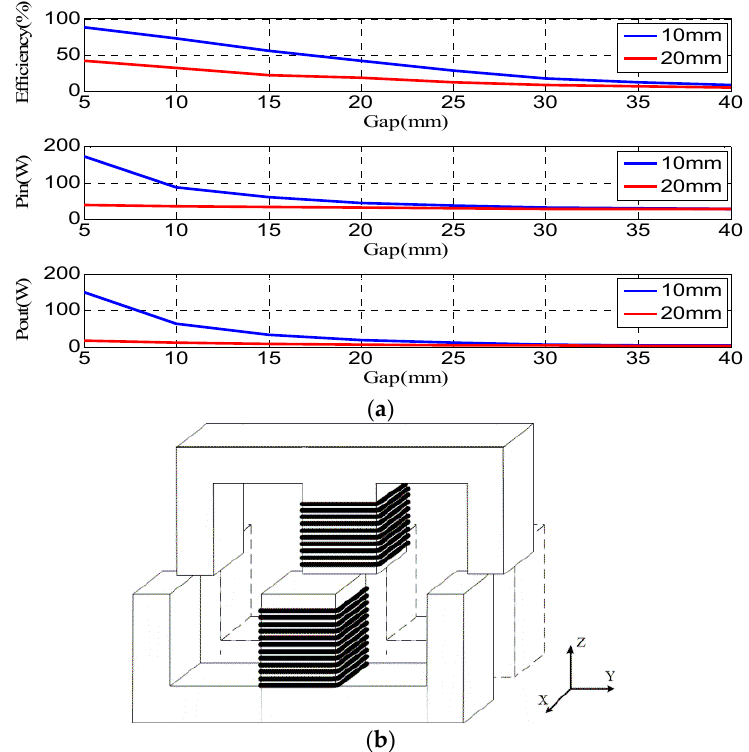
Figure 7. Dislocation effect of the IPT system with varied air gap from 5 mm to 40 mm (fsw: 20 kHz). ( a ) Efficiency, input power; and output power ( b ) Dislocation. Table 5. Dislocation effect of the IPT system with varied air gap from 5 mm to 40